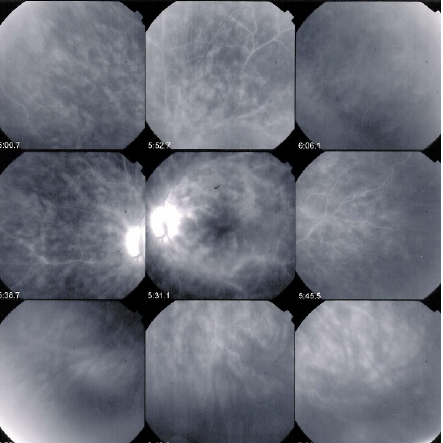
Figure 3. HLA-A29 birdshot retinochoroiditis. Diffuse retinal vasculitis involving vessels of all sizes,